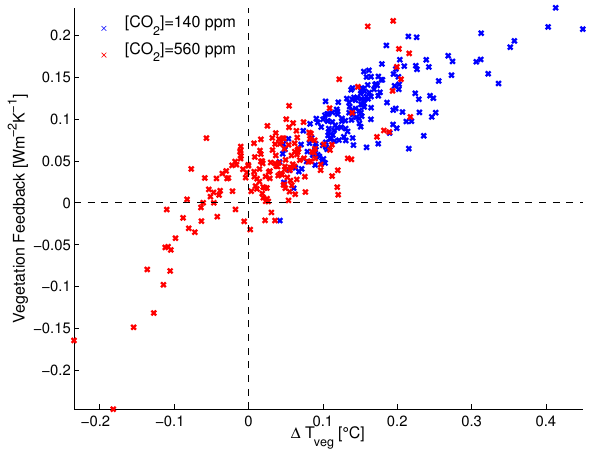
Fig. 13. Global vegetation feedback factor vs. global tempera- ture difference between interactive and prescribed vegetation ex- periments ( 1T veg = T RPLV − T R ) for all ensemble members. Red crosses represent the experiments with 560 ppm and blue crosses those with 140 ppm. The sign of 1T veg is reversed in the 140 ppm case to allow a direct comparison with the 560 ppm case. In reality 1T veg values are negative for all ensemble members in the 140 ppm experiments. A positive vegetation feedback indicates a vegetation induced global cooling for CO 2 halving and a global warming for CO 2